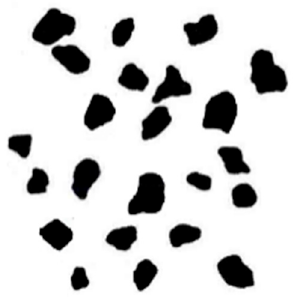
Figure 2. The shape of soil particles of saturated silt along Yangtze River.